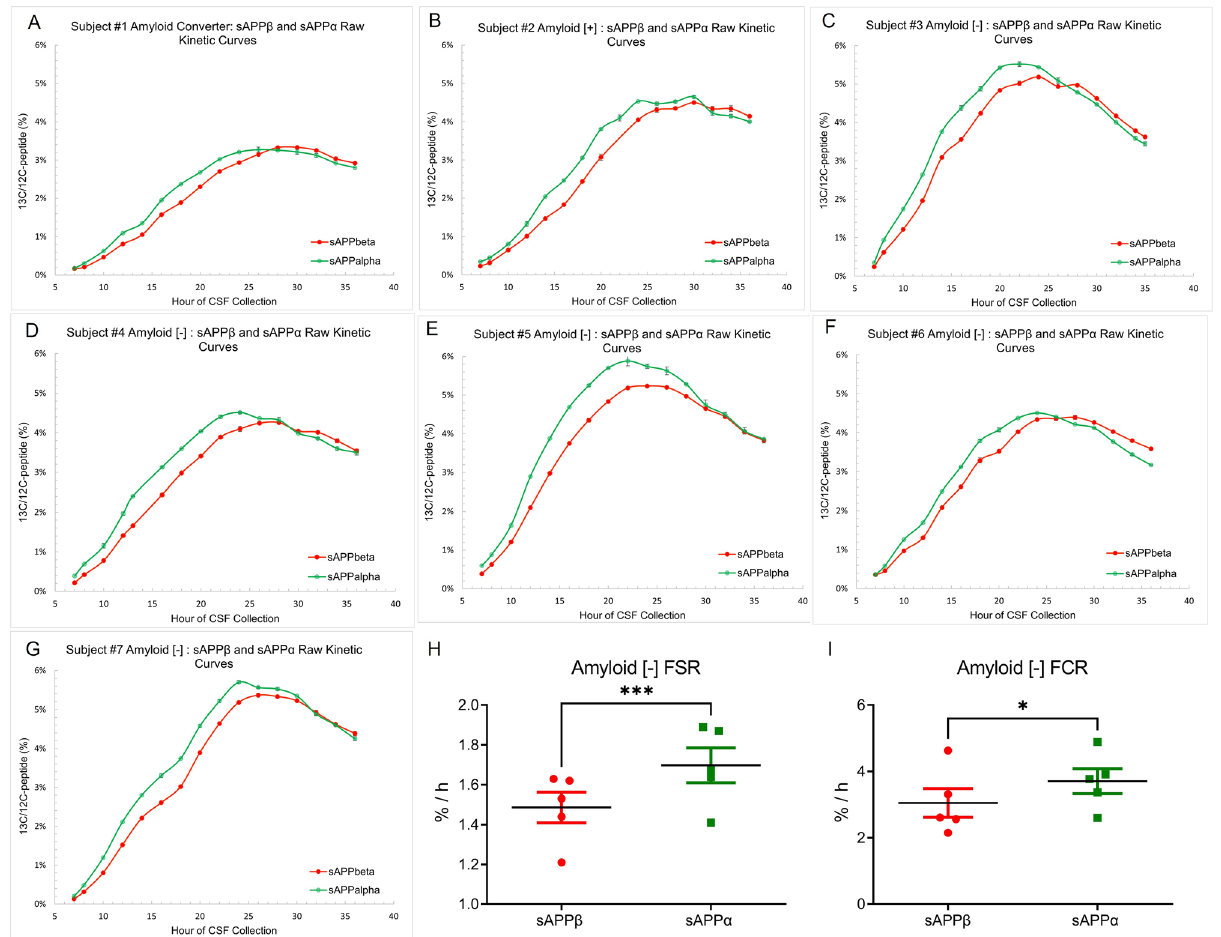
Figure 4. sAPPβ (red) and sAPPα (green) raw kinetic curves generated from 7 participants. Curves represent raw LC/MS data (labeled/unlabeled (%)) at each data point during the 36 h CSF collection period. Error bars represent SEM with the data point comprising an average value of duplicate or triplicate injections of a single time-point sample. ( A ) Subject #1 is an AD amyloid converter. ( B ) Subject #2 is AD Amyloid [+]. ( C–G ) Subjects #3–7 are Amyloid [−]. ( H ) Fractional synthesis rate (FSR) of the Amyloid [−] subjects is significantly lower for sAPPβ than for sAPPα [1.49 ± 0.17%/h vs. 1.7 ± 0.2%/h (mean ± SEM), respectively; ***p = 0.0004 using paired t-test]. ( I ) Fractional clearance rate (FCR) of the Amyloid [−] subjects is significantly lower for sAPPβ than for sAPPα [3.05 ± 0.98%/h vs. 3.71 ± 0.83%/h (mean ± SEM), respectively; *p = 0.013 using paired t-test].